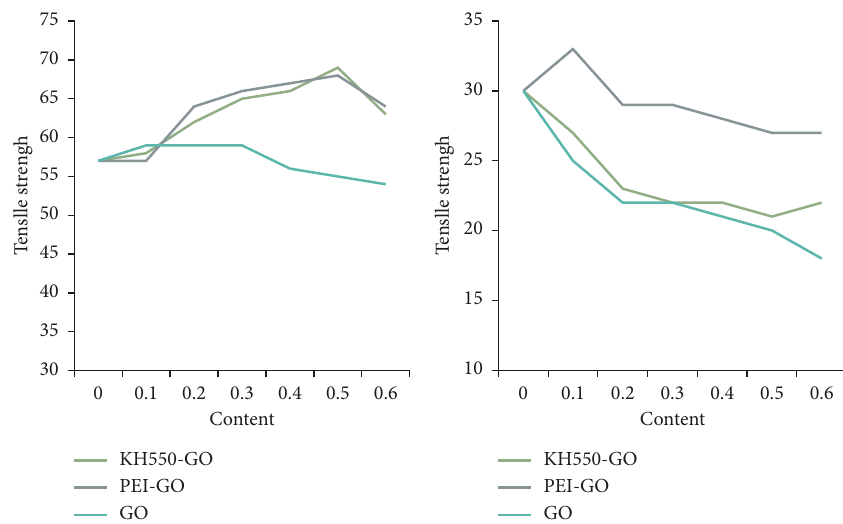
Figure 6: Schematic diagram of the secondary mechanical properties of the composite material.